Question: Name the type of graph shown.
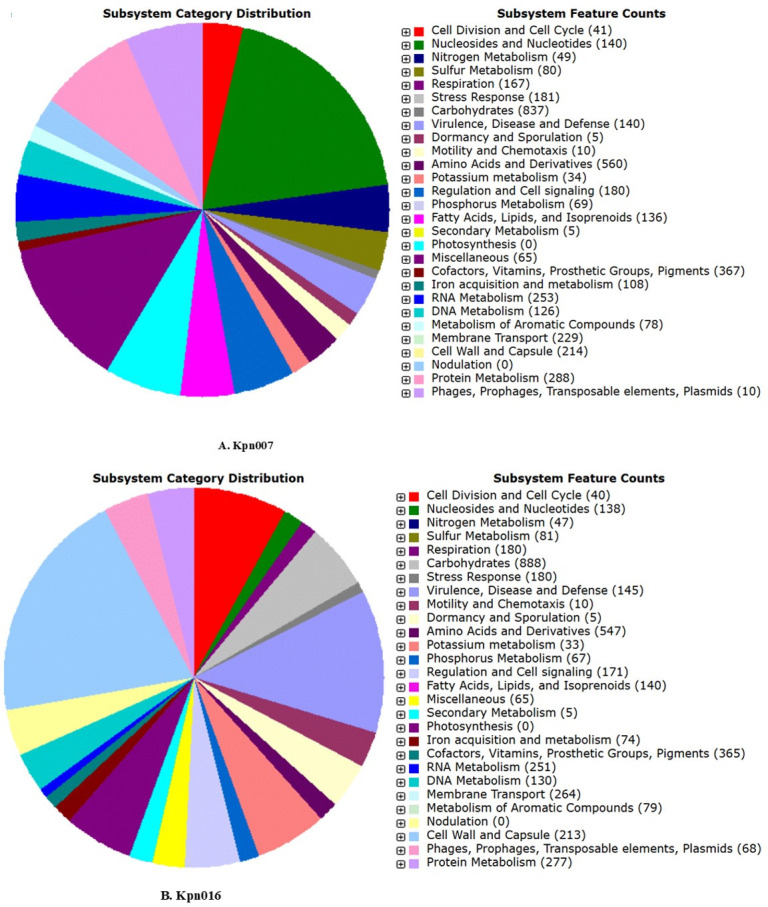
Answer: pie